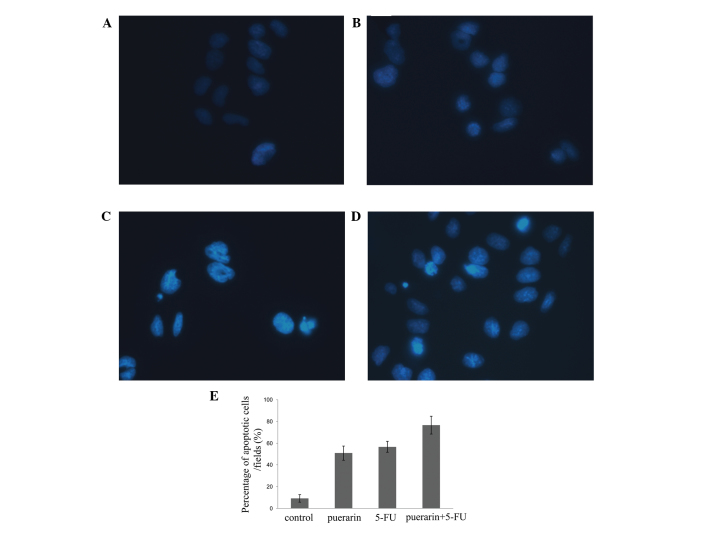
Detection of apoptosis-related morphological changes by Hoechst 33258 staining in SMMC7721 cells. (A) Control cells and cells exposed to (B) puerarin (1,600 μM), (C) 5-FU (160 μM) or (D) puerarin and 5-FU for 48 h were then incubated with 20 μM Hoechst 33258 for 10 min at room temperature. Apoptotic cells were identified by chromatin condensation and nuclear fragment staining. (E) The apoptotic cell rate in combined treatment group was higher than that of the puerarin and 5FU alone. Data are presented as the mean ± SD. *P<0.05, vs. control cells.